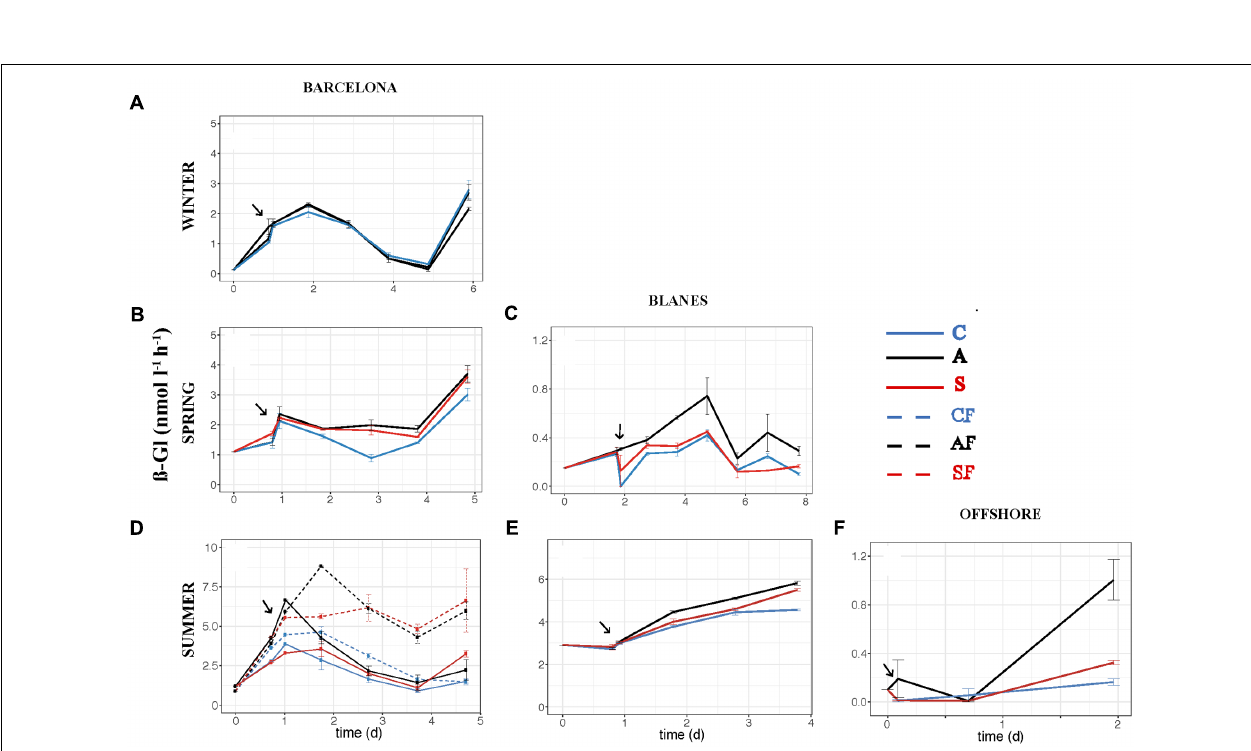
FIGURE 6 | Activity of ß-glucosidase – ß-Gl (nmol l − 1 h − 1 ) – over the incubation time in the six experiments: (A) WI-BCN, (B) SP-BCN, (C) SP-BLA, (D) SU-BCN, (E) SU-BLA, (F) SU-OFF. The same abbreviations and comments than in Figure 3 are applicable.